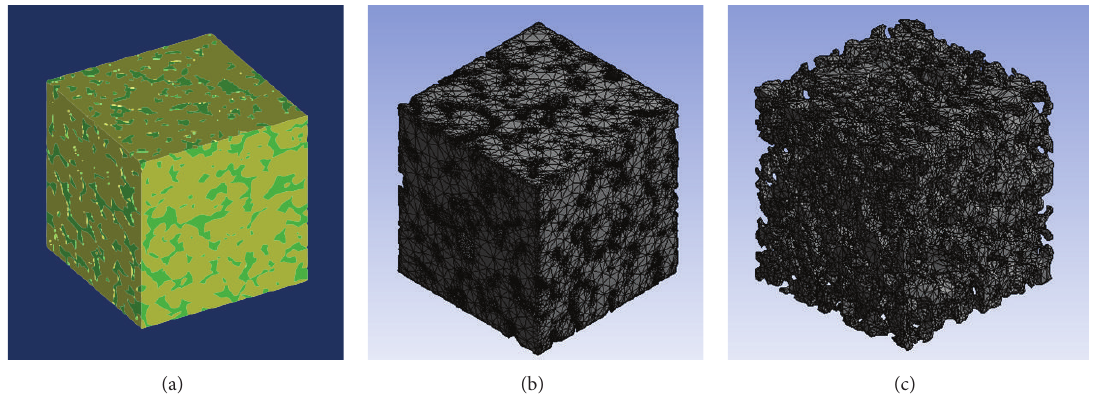
Figure 3: Reconstruction model, matrix, and pore space finite element model of S2.